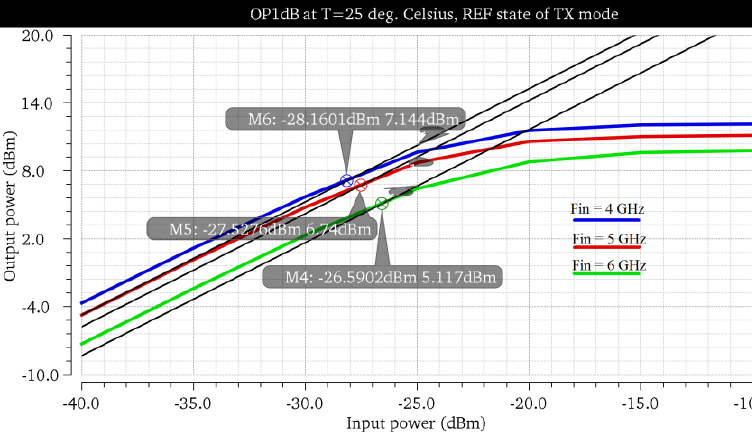
Fig. 10. Tx mode output 1 dB compression point simulation